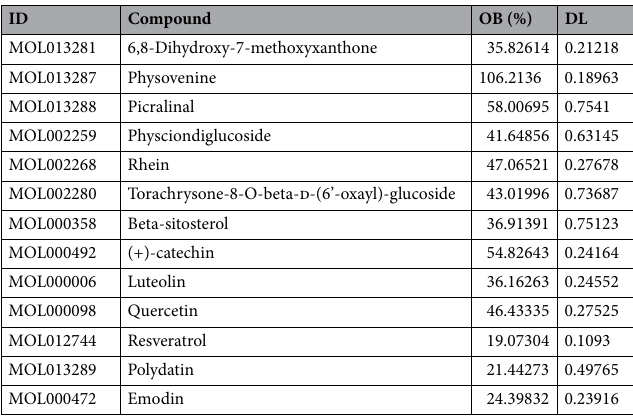
Table 1. The total available compounds of Polygoni Cuspidati.